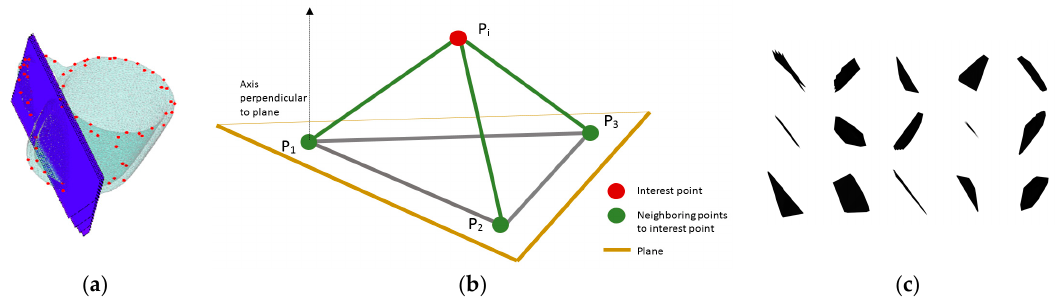
Figure 2. Tactile data acquisition simulation: ( a ) 3D object in contact with the 4 quasi-tangent planes ( b ) the first plane computation; and ( c ) series of tactile imprints obtained for the